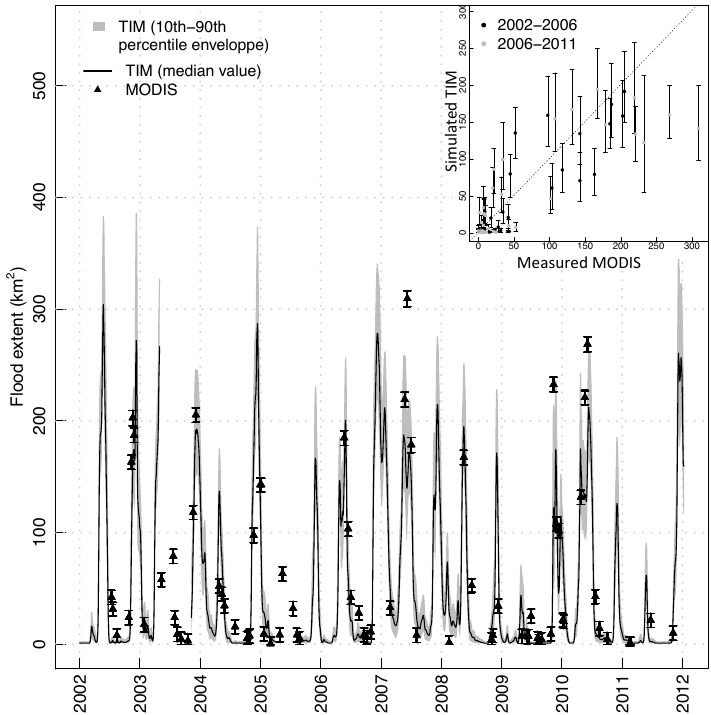
Fig. 6. Flood extent in the delta for 2002–2011, as computed by TIM or measured from the MODIS imagery.